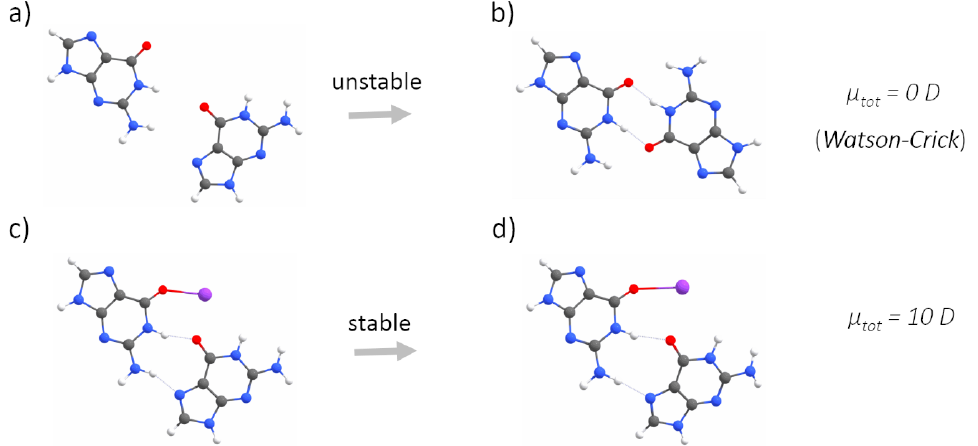
Figure 4. The optimizations of two adjacent guanines without ( a → b ) and with ( c → d ) metal (here potassium) cations, calculated at the QM level of theory. The optimization without a cation leads to the cancellation of the dipole moments by a pronounced mutual rearrangement of the guanines, driving the residues to interact with hydrogen bonds via Watson–Crick edges. The presence of the cation stabilized the mutual orientation of guanines, favouring hydrogen bonding via Hoogsteen edges, despite a non-zero total dipole moment of the system.